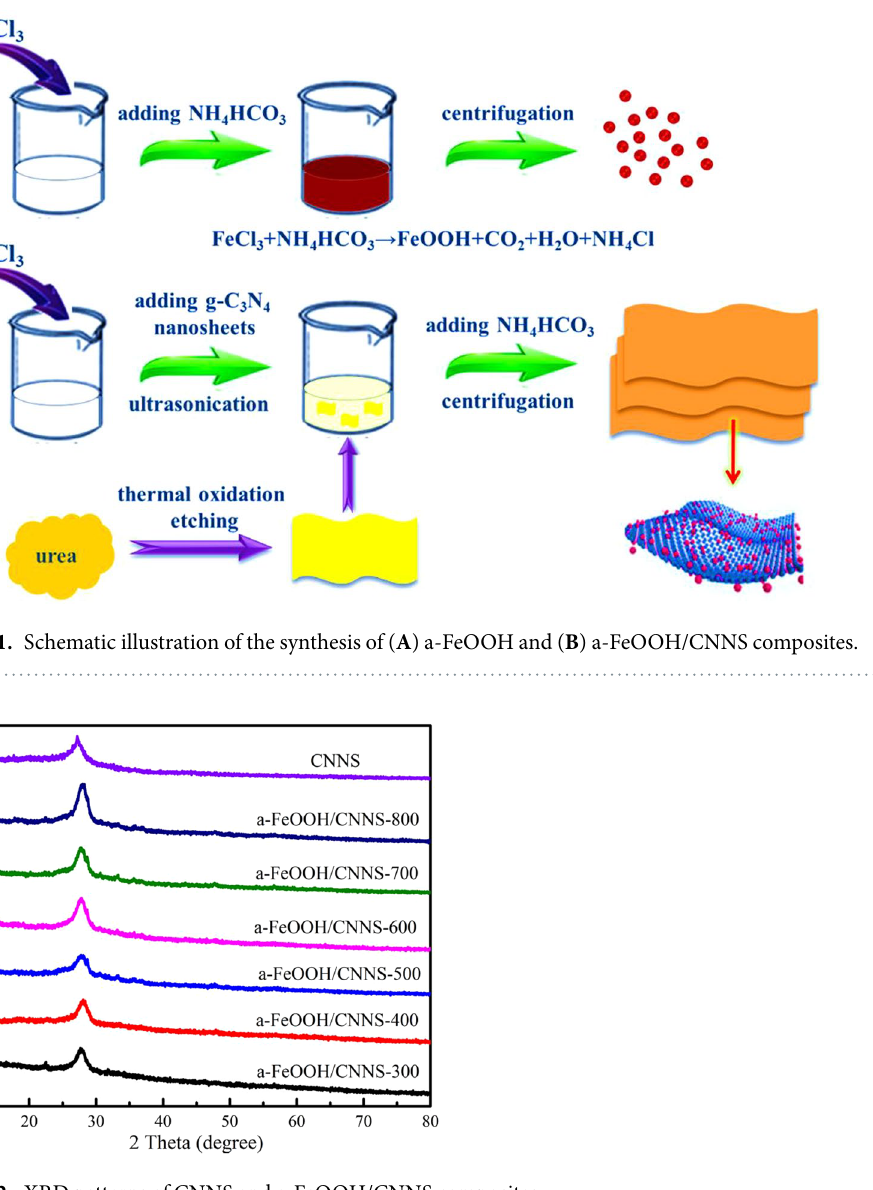
Figure 2. XRD patterns of CNNS and a-FeOOH/CNNS